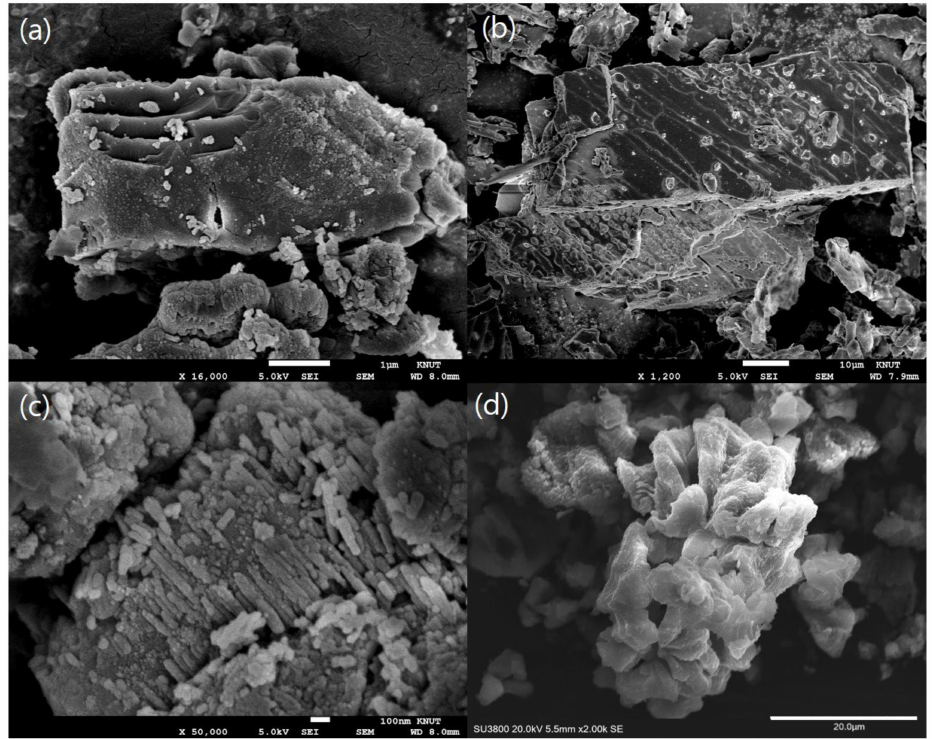
Figure 13. Scanning electron microscope (SEM) image: ( a ) CC6. ( b ) CC7. ( c , d )